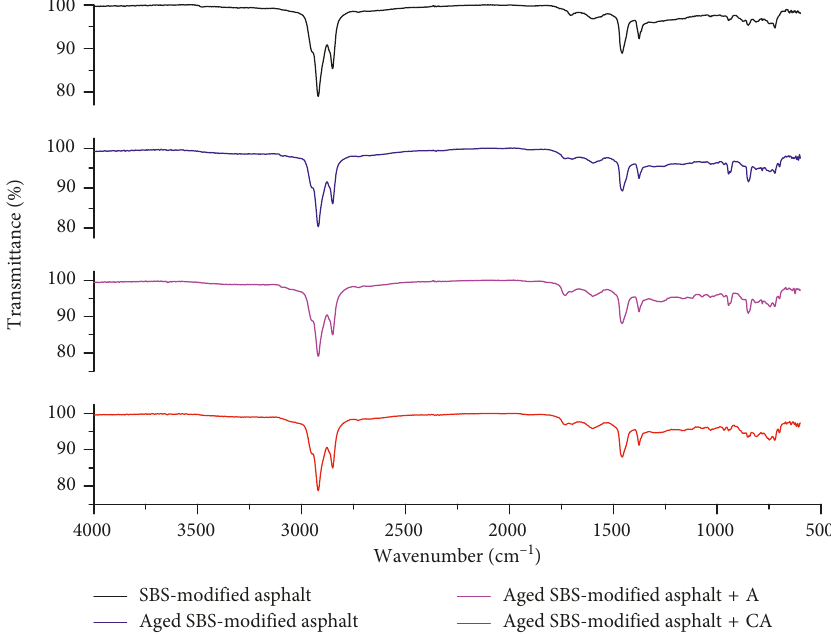
Figure 15: Comparison of FTIR spectra of several SBS-modified asphalt